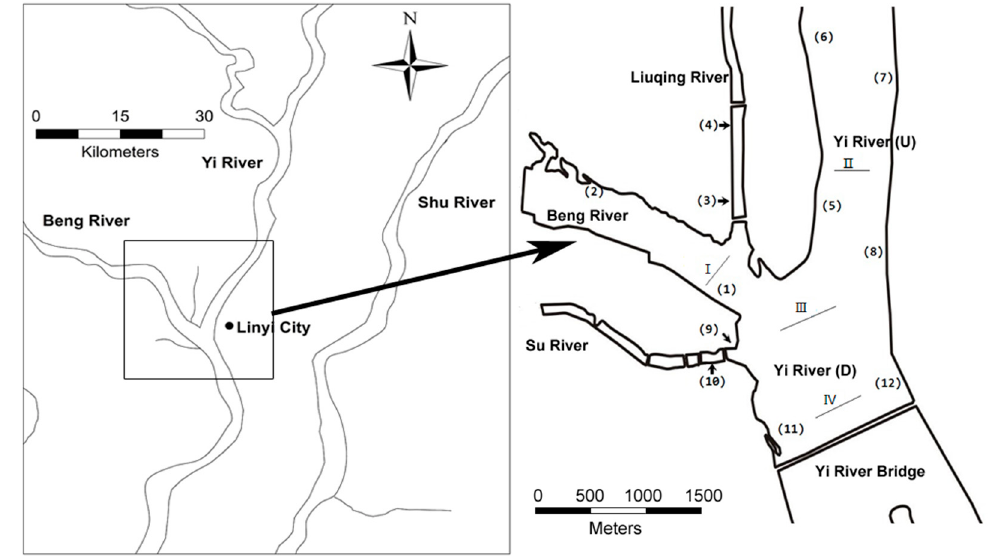
Figure 1. Location of sampling sites in the junction of rivers in Linyi City, China. Number (1) to (12) represent sampling sites of water and aquatic plants. Number I to IV represent sampling sites of the sediments.